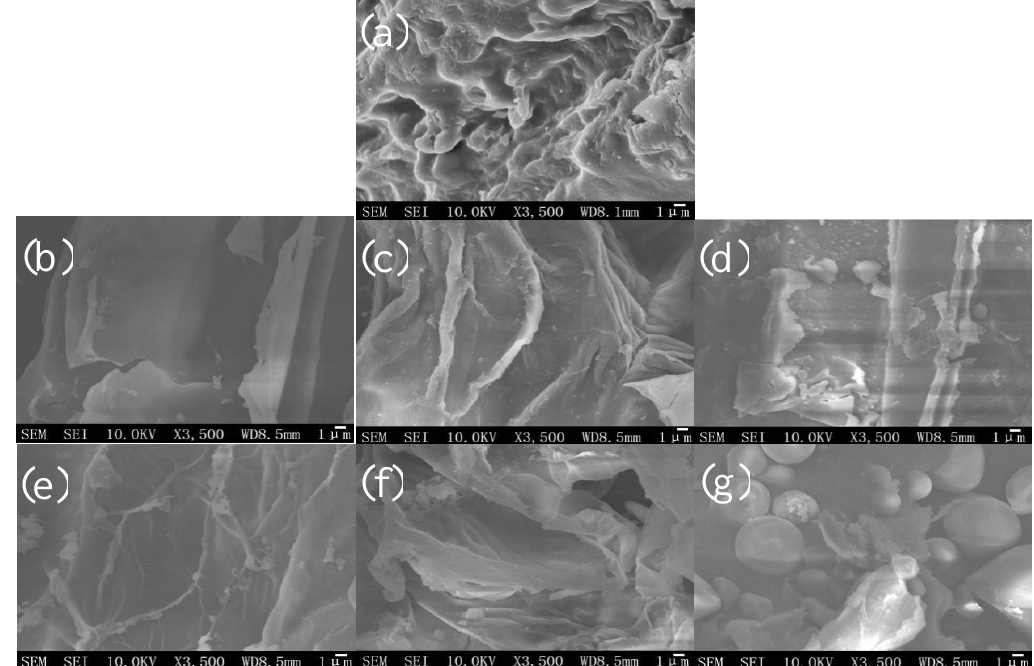
Figure 3. SEM images of Scutellaria baicalensis Georgi samples. ( a ) Raw materials; ( b )DES-based UPE; ( c ) DES-based MAE; ( d ) DES-based HRAE; ( e ) 70% ethanol-based UPE; ( f ) 70% ethanol-based MAE; ( g ) 70% ethanol -based HRAE.